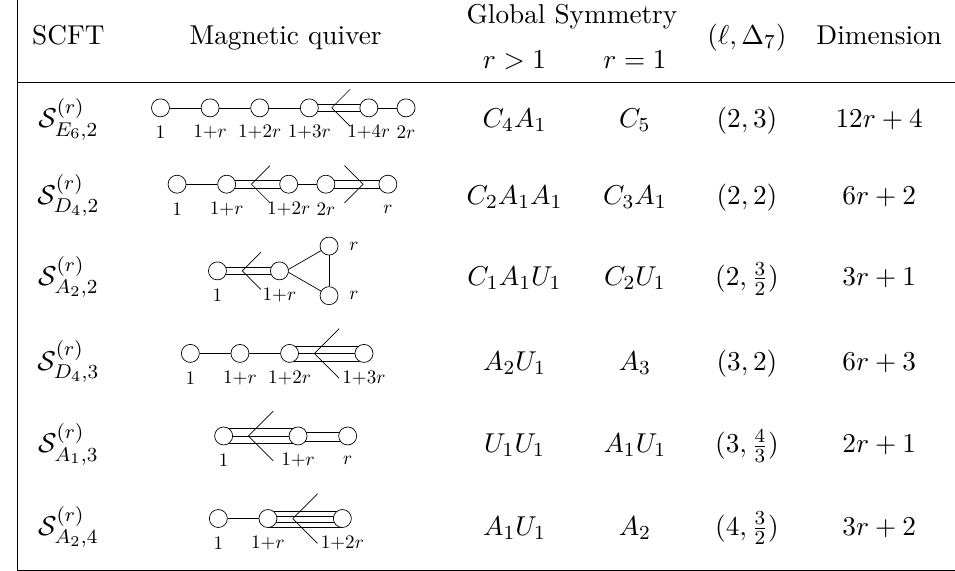
Table 1. The magnetic quivers of 4d N = 2 rank r S -fold theories. The Higgs branch dimension of S ( r ) is (6 r + ‘ )(∆ 1) , which matches the Coulomb branch dimension of the magnetic quiver. 7 − G,‘ The folding parameter ‘ also indicates the multiplicity of the non-simply laced edge. The global symmetry of the magnetic quiver displays the expected enhancement for r = 1 [4]. Recall that a U(1) is ungauged on a long node for all the